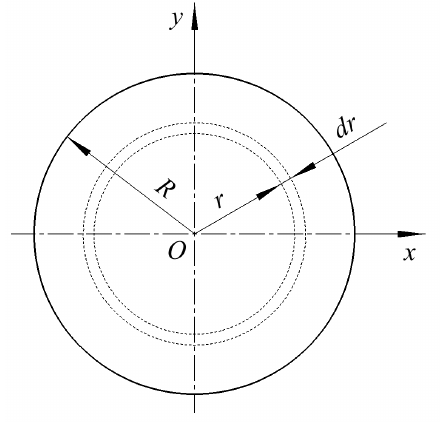
Figure 3. Pipeline cross-section and